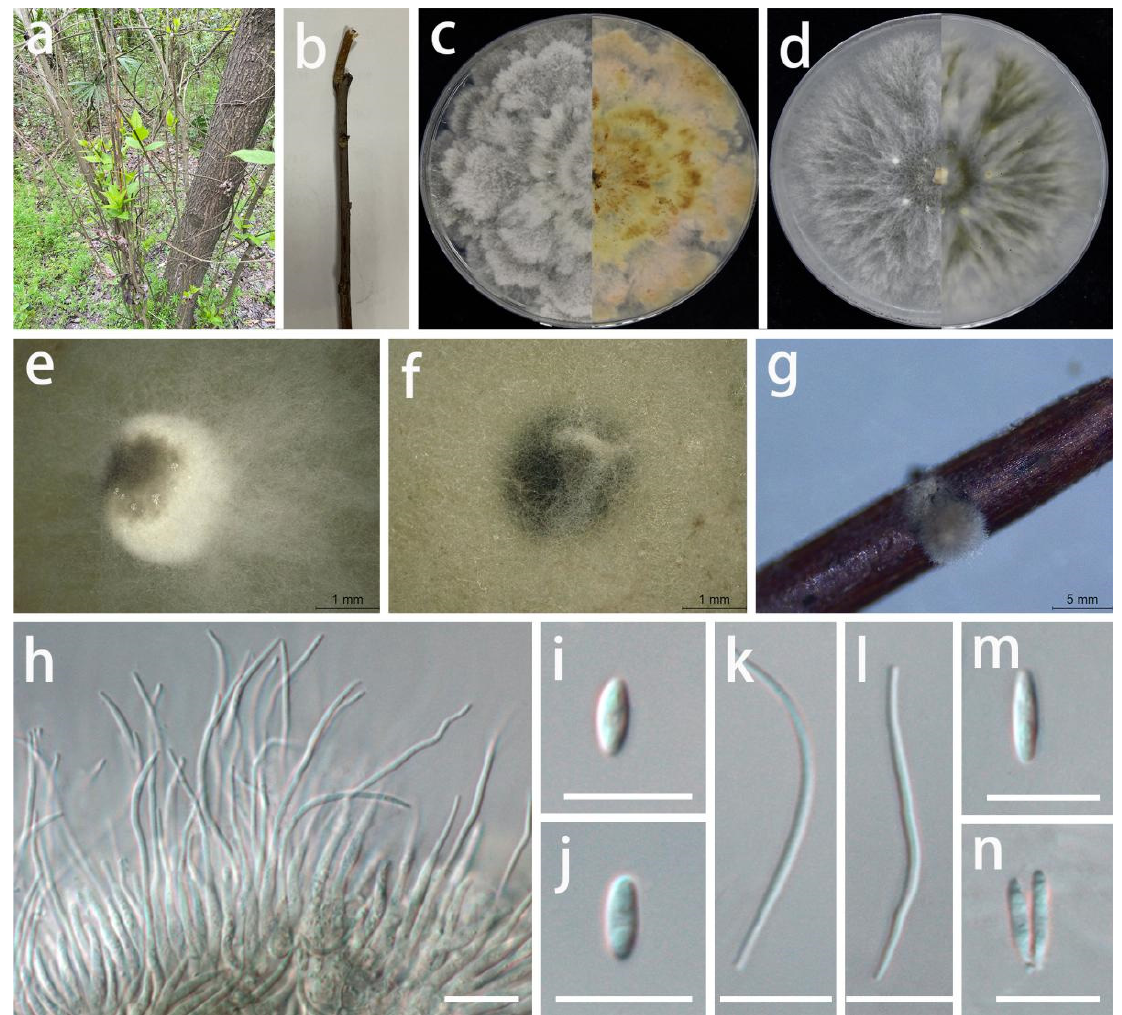
Figure 8. Diaporthe eucommiigena (GUCC 420.9). ( a , b ) Host: Eucommia ulmoides . ( c ) Colony on PDA after 2 wk at 25 °C (left: above, right: reverse). ( d ) Colony on OA after 2 wk at 25 °C (left: above, right: reverse). ( e – g ) Mass of conidia. ( h ) Conidiogenous cells. ( i , j ) Alpha conidia. ( k , l ) Beta conidia. ( m , n ) Gamma conidia. Scale bars: ( h – n ) = 10 μ m.